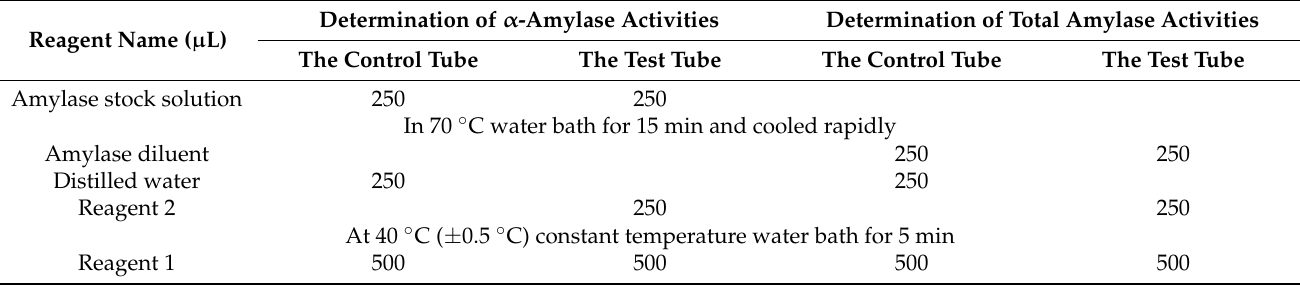
Table 1. The measurement of amylase